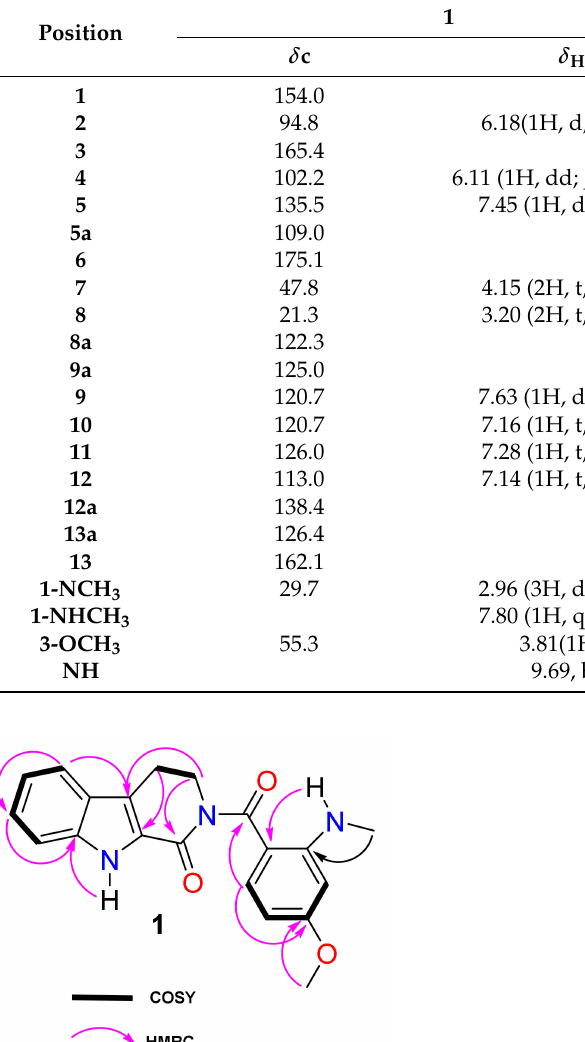
Table 1. 1 H-NMR data (600 MHz, CDCl 3 ) and 13 C-NMR data (150 MHz, CDCl 3 ) of soyauxinine ( 1 ).